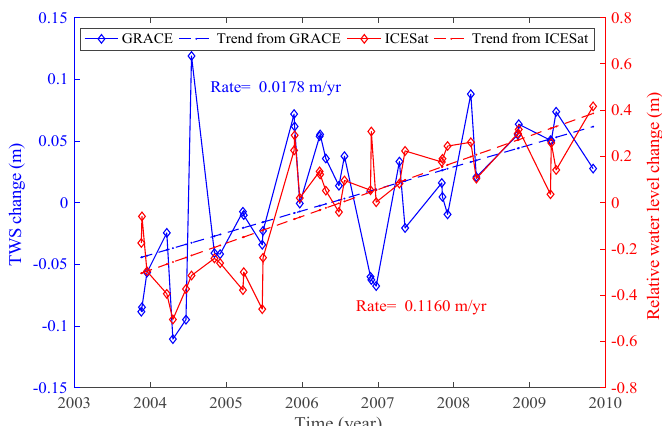
Figure 14. Time series of the ICESat relative water level changes and the GRACE (area-averaged) water storage changes (in terms of the equivalent water thickness) of Qinghai Lake.